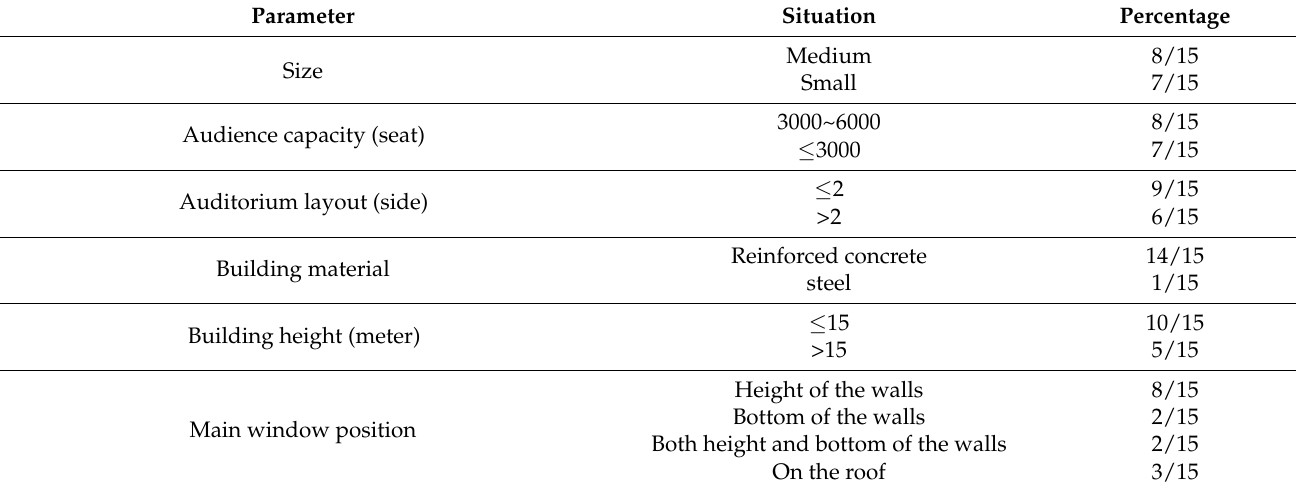
Table 2. Information of naturally ventilated gymnasiums in Guangzhou